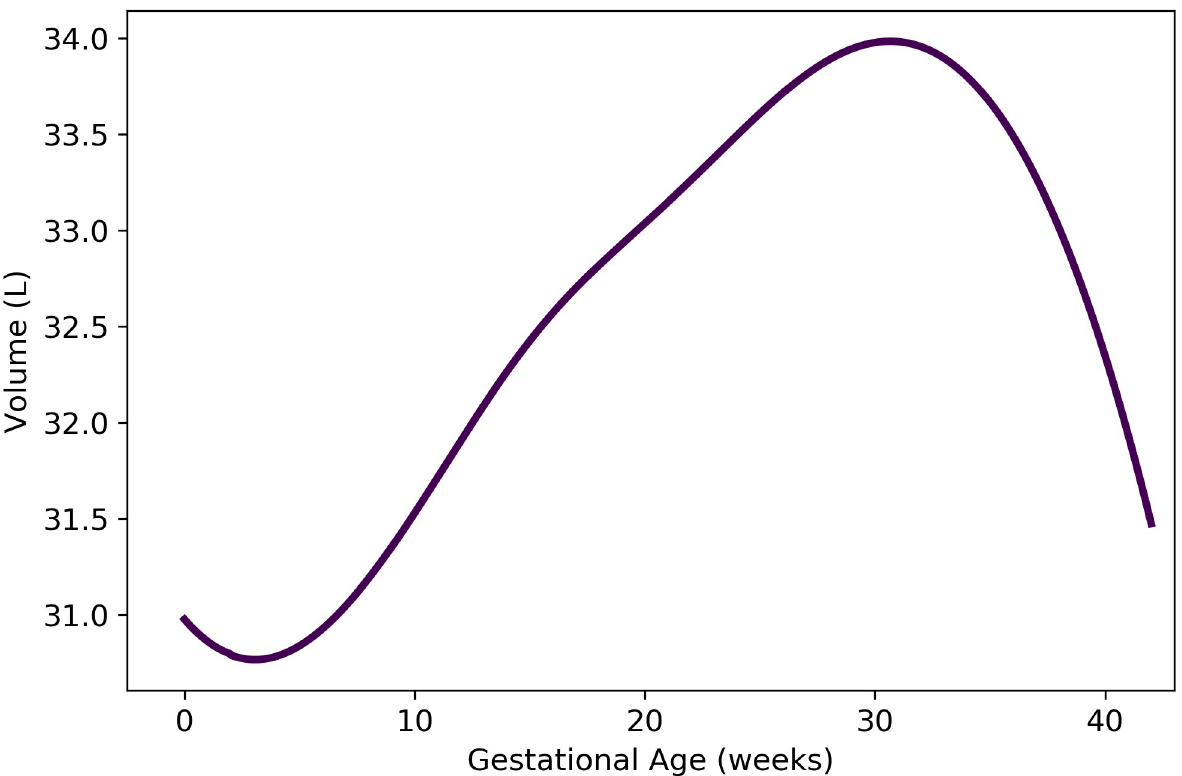
Fig 8. Volume of maternal “rest of body” compartment vs. gestational age. The formula for the depicted model, which is based on mass balance, is provided as Eq 12.